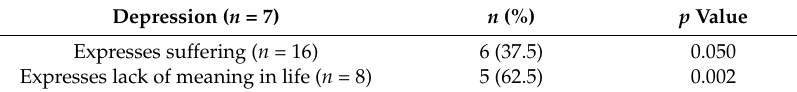
Table 2. Depression related to the main defining characteristics of spiritual distress.